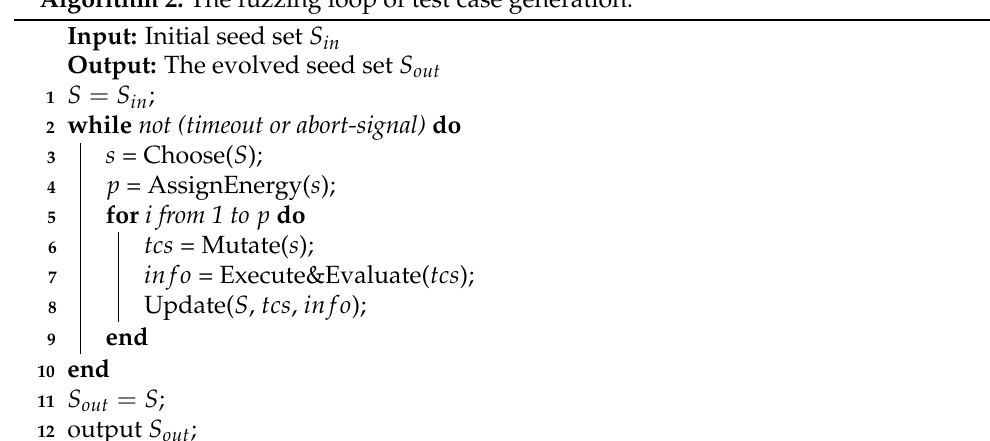
Algorithm 2: The fuzzing loop of test case